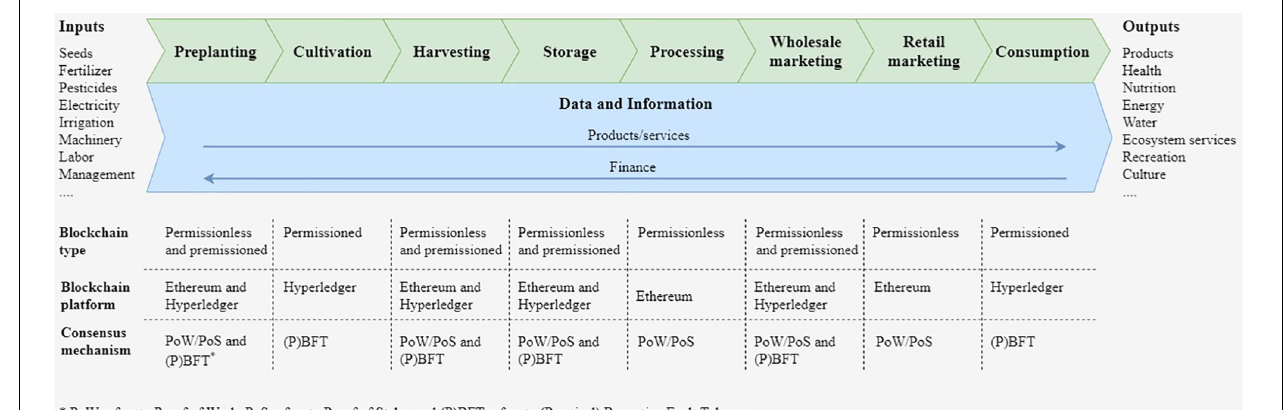
FIGURE 1 | Data and information flow along the food value